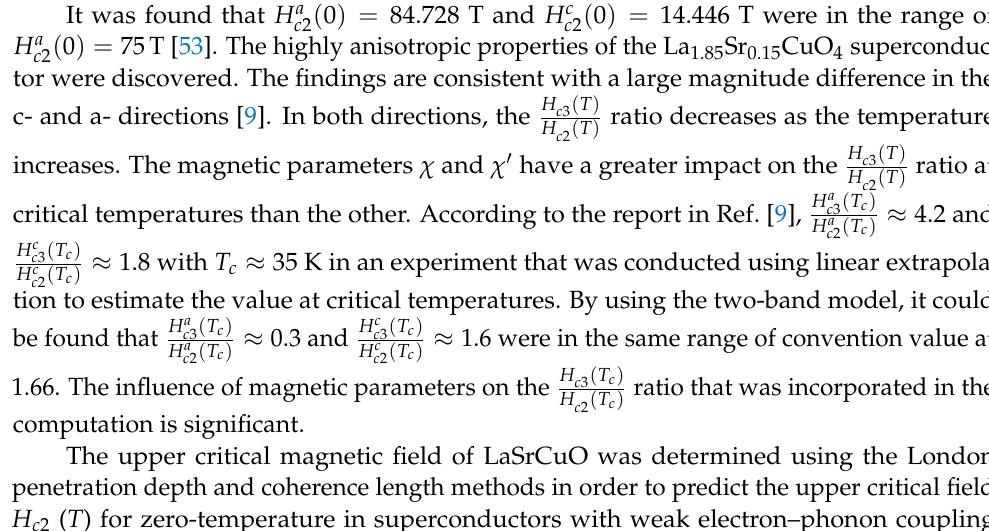
Figure 6. The anisotropic shape of the first and second bands of La 1.85 Sr 0.15 CuO 4 -c superconductor. ( 0 ) = 84.728 T and H c ( 0 ) = 14.446 T were in the range of It was found that H a c 2 c 2 ( 0 ) = 75 T [53]. The highly anisotropic properties of the La H a 1.85 Sr 0.15 CuO 4 superconduc- c 2 tor were discovered. The findings are consistent with a large magnitude difference in the H c 3 ( T ) c- and a- directions [9]. In both directions, the ratio decreases as the temperature H c 2 ( T ) H c 3 ( T ) increases. The magnetic parameters χ and χ (cid:48) have a greater impact on the ratio at H c 2 ( T ) H a c 3 ( T c ) ≈ 4.2 and critical temperatures than the other. According to the report in Ref. [9], H a c 2 ( T c ) H c c 3 ( T c ) H